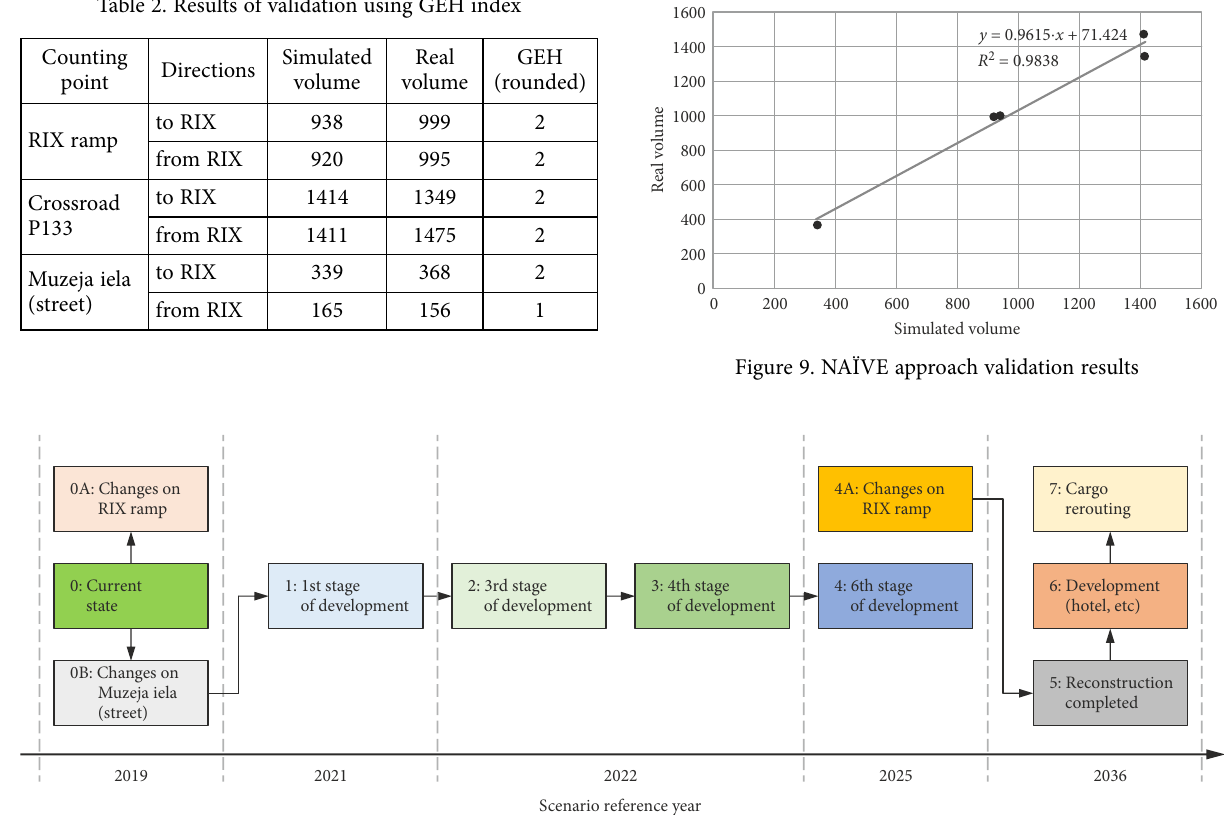
Figure 10. Scenario